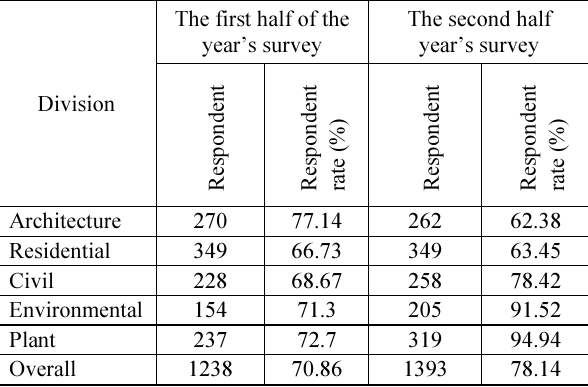
Table 1. Overview of the survey